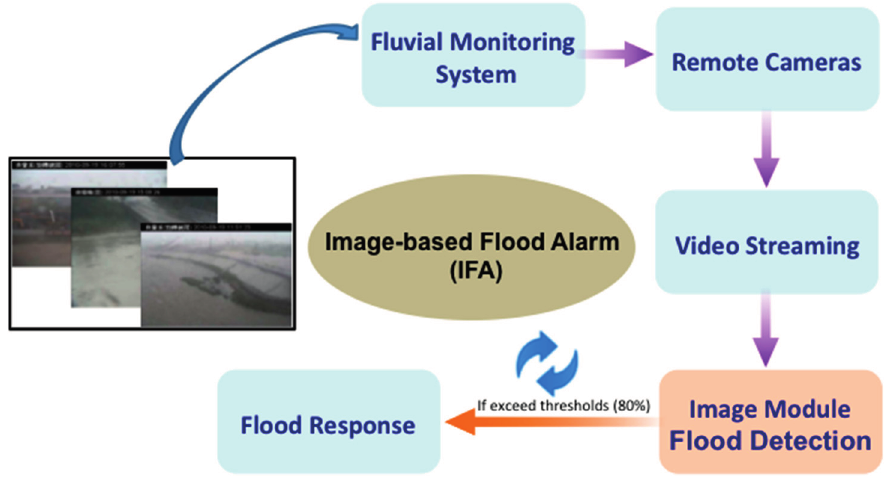
Figure 1. Flowchart of the proposed image-based flood alarm (IFA)